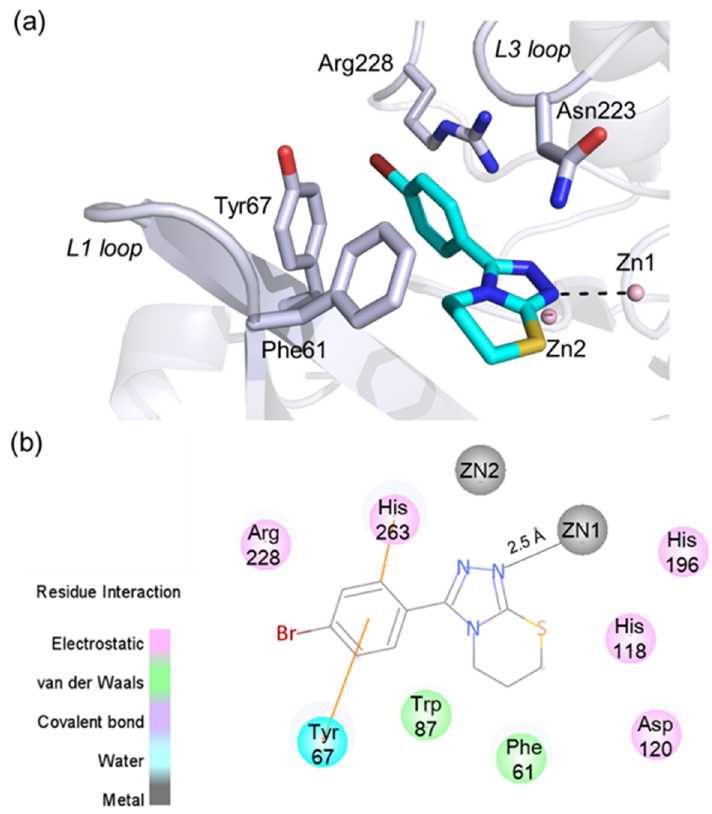
Figure 5. The predicted binding pose of 5l with VIM-2. ( a ) A view of the docking pose of 5l with VIM- 2, showing interactions with the active site zinc ions and catalytically important residues (e.g., Tyr67 and Phe61); ( b ) 2D protein–ligand interactions between 5l and VIM-2 defined using the Discovery Studio